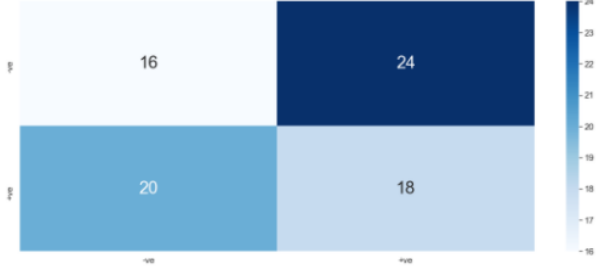
Figure 20. SVM Confusion Matrix with RBF